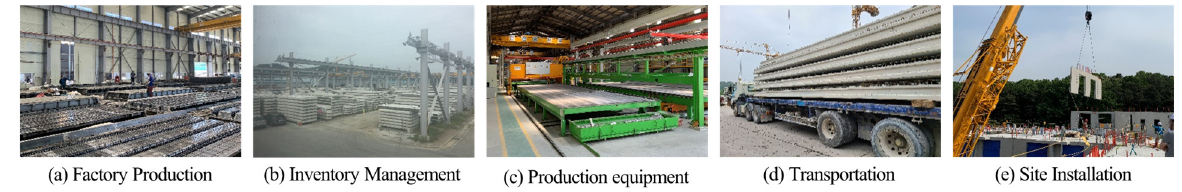
Figure 3. Managerial characteristics of OSC projects.